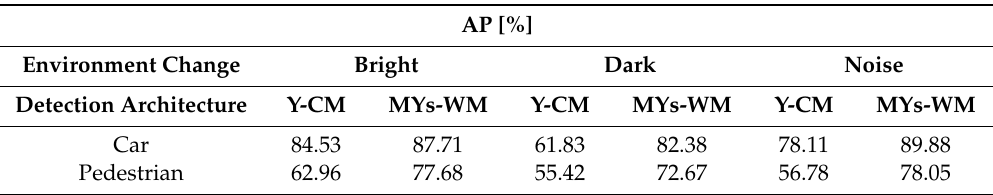
Table 5. Robustness to external environment